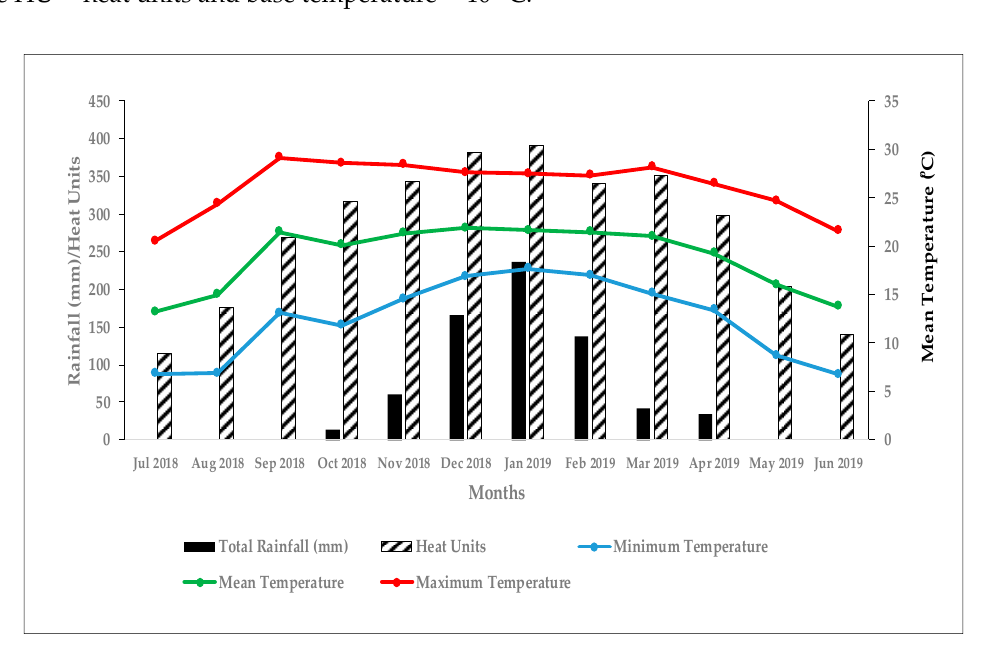
Figure 2. Monthly rainfall, heat units, mean, maximum, and minimum monthly temperatures during the crop growing season (November 2018–April 2019).